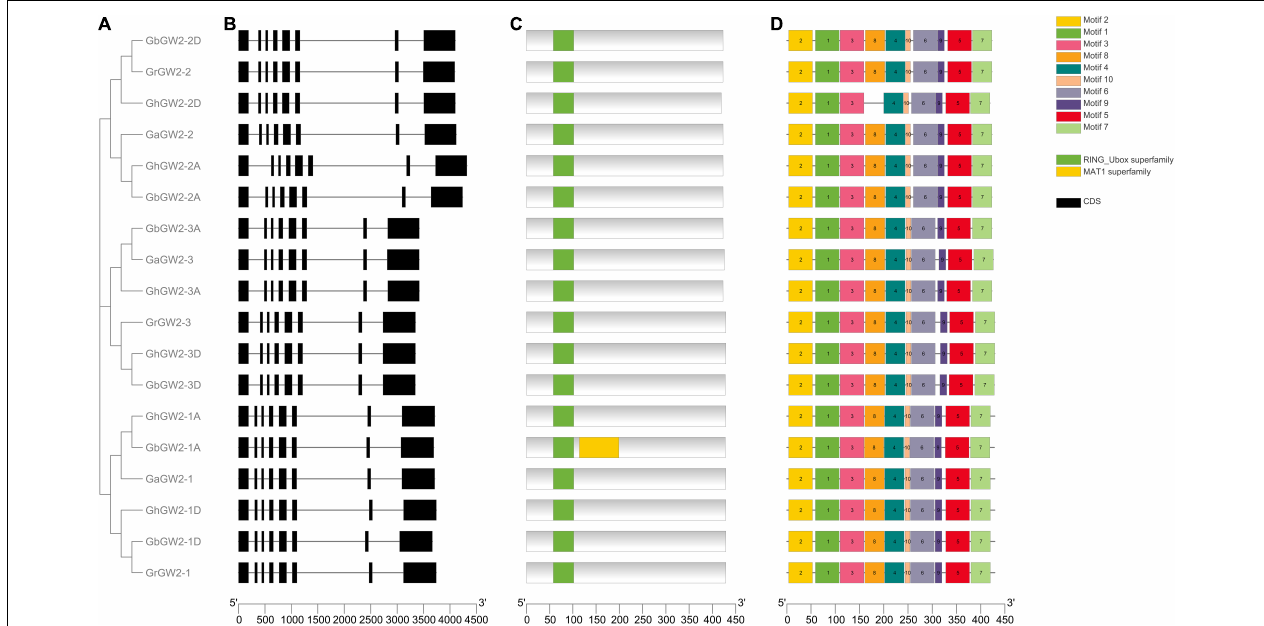
FIGURE 1 | Phylogenetic analysis, gene structure, and protein domain analyses of GW2- like genes in Gossypium . (A) Phylogenetic tree of GW2- like genes in Gossypium . Phylogenetic tree was constructed using MEGA 7.0 by Neighbor-Joining method with 1,000 bootstrap replicates. (B) The exon-intron structure of GW2- like genes. (C) GW2-like protein domain prediction. (D) The motifs prediction of GW2-like protein.